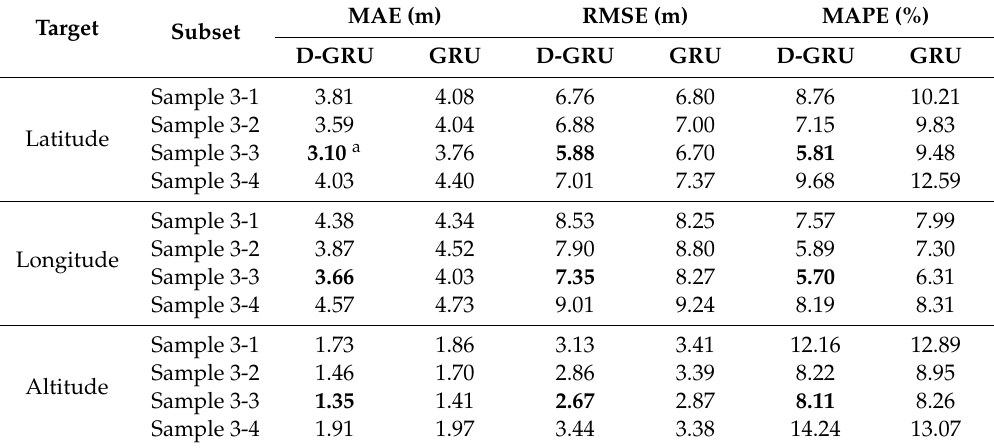
Table 4. Comparison of the prediction accuracy with di ff erent training samples for Mavic 2 quadrotors. MAE (m) RMSE Target Subset